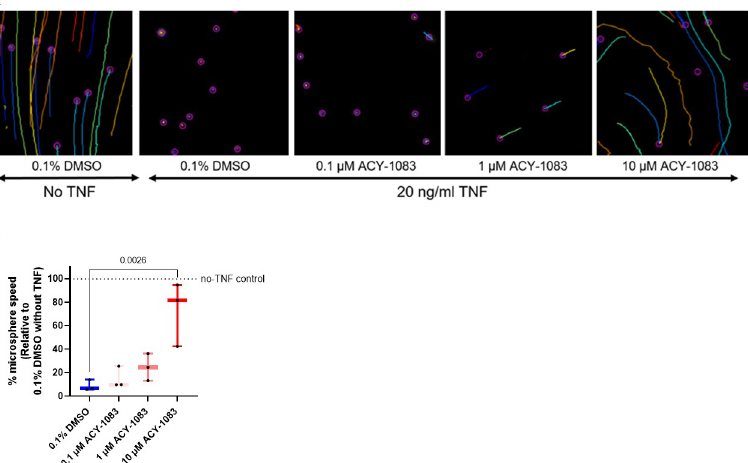
Fig 6. ACY-1083 maintains mucociliary clearance during TNF-challenge. Mucociliary transport rates were determined by tracking fluorescent microspheres placed on top of cell layer of unchallenged or TNF-challenged HBEC ALI cultures with or without ACY-1083 treatment. (A) Images of tracked beads in the ImageJ software with the Fiji plugin Tracking. Lines show movement of beads. (B) Microsphere speeds determined from 3 COPD donors and three fields per well. Box plot with dots representing 3 COPD donors and whiskers showing min and max. Data was normalized to the DMSO-control without TNF for each donor (set to 100%). Statistical analysis was performed using one-way ANOVA with Dunnett´s multiple comparisons